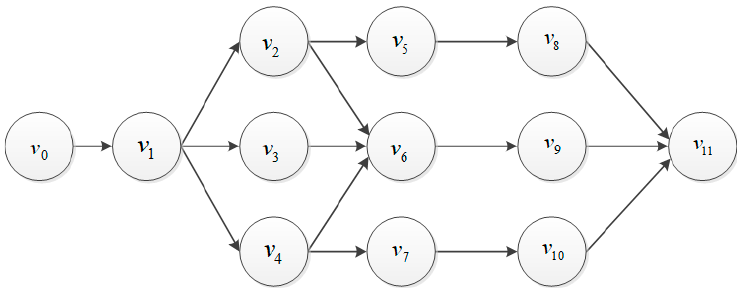
Figure 2. The application model generated by user equipment (UE).